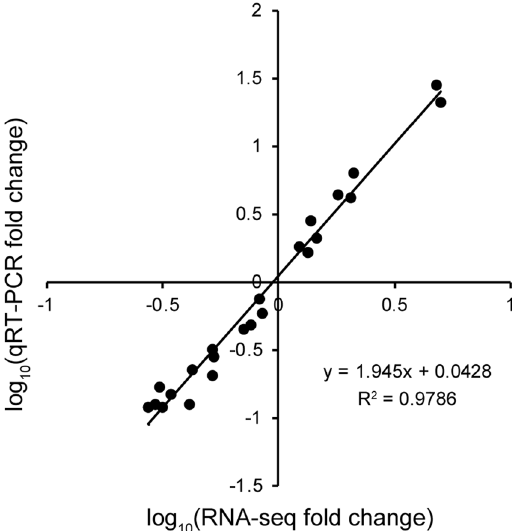
Figure 7. Correlation analyses of fold change values obtained from qRT-PCR and RNA-Seq. RNA-Seq fold change means the ratios of RPKM values of three developmental stages of spikes in two cultivars for selected genes, and qRT-PCR fold change is the relative quantity of the select genes normalised to the expression level of β -actin